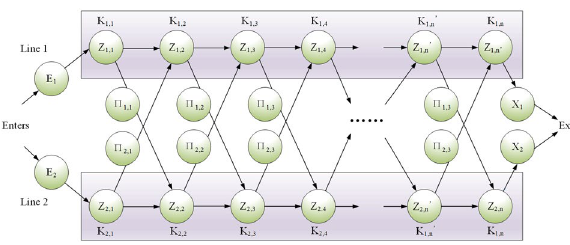
Figure 7. Dynamic programming multistage decision concept